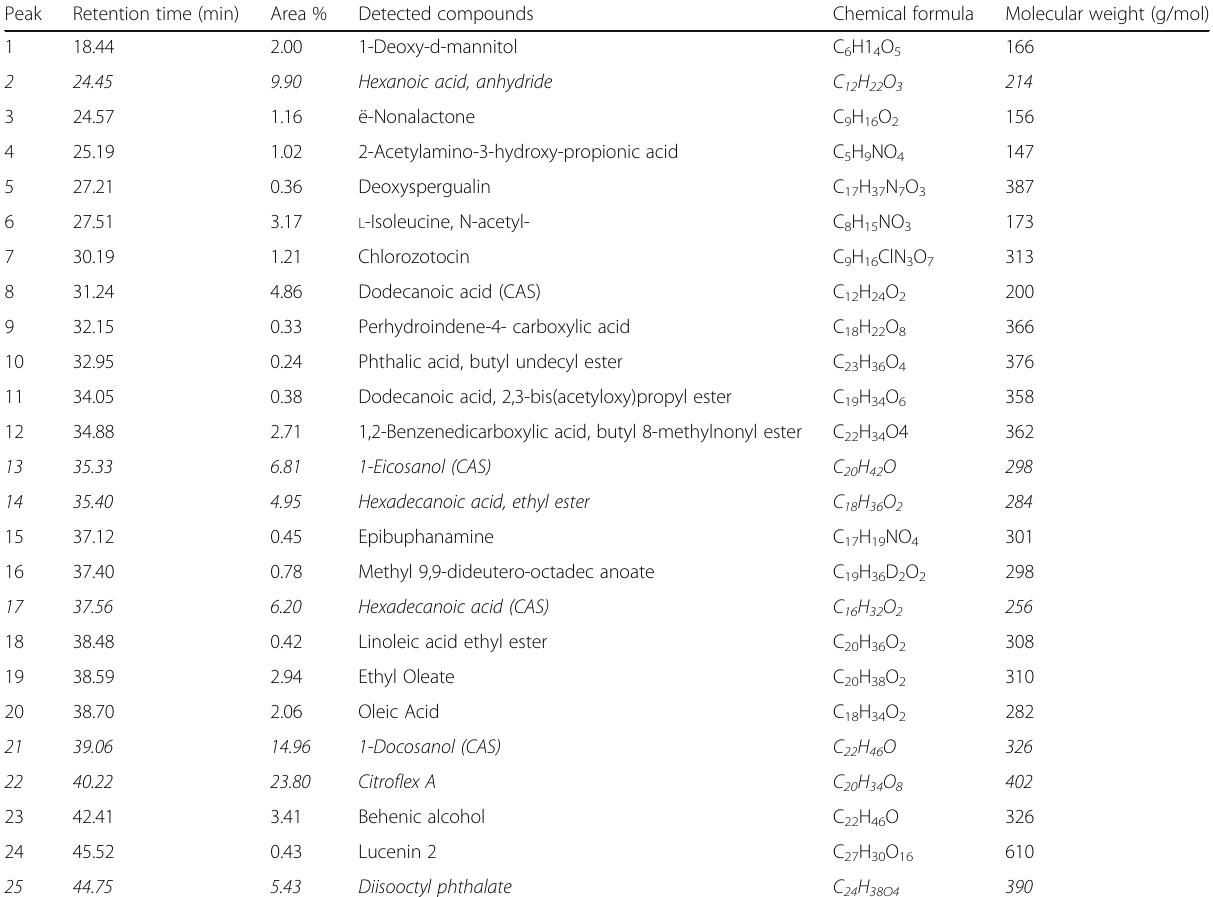
Shaded rows with italic font represent compounds with high abundance among other detected compounds (high